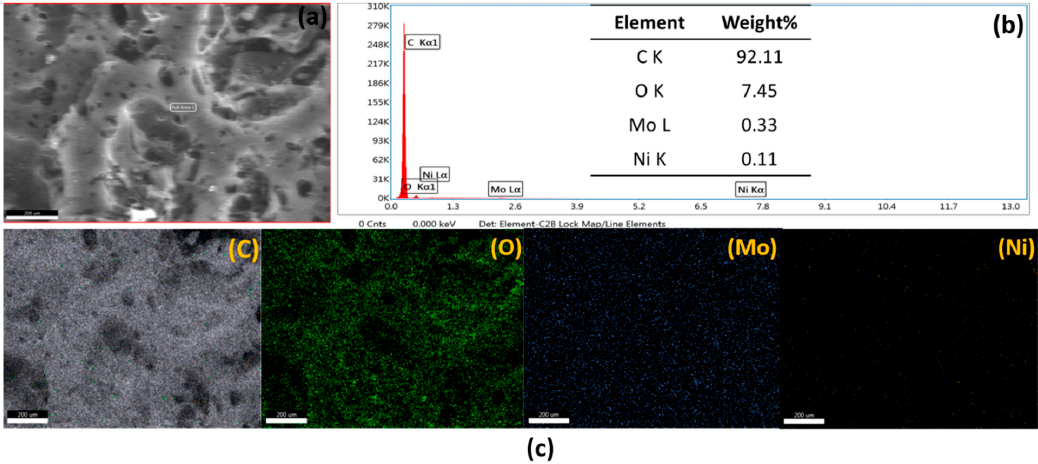
Figure 6. FESEM-EDX elemental mapping analysis for NiMo3/AC. ( a ) The full area of elemental mapping ( b ) EDX analysis ( c ) Elemental distribution of C, O, Mo and Ni. mapping ( b ) EDX analysis ( c ) Elemental distribution of C, O, Mo and